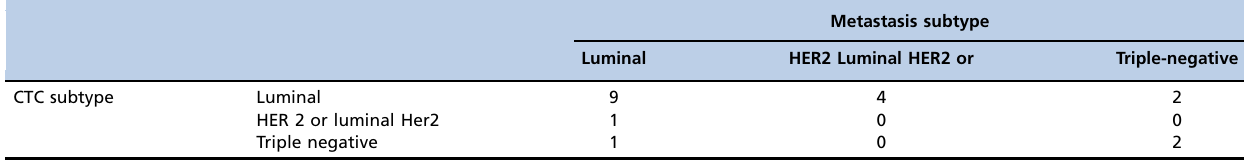
Table S1 - Concordance between CTC and metastasis